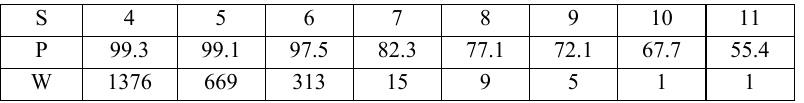
Table 1. Dynamic simulation